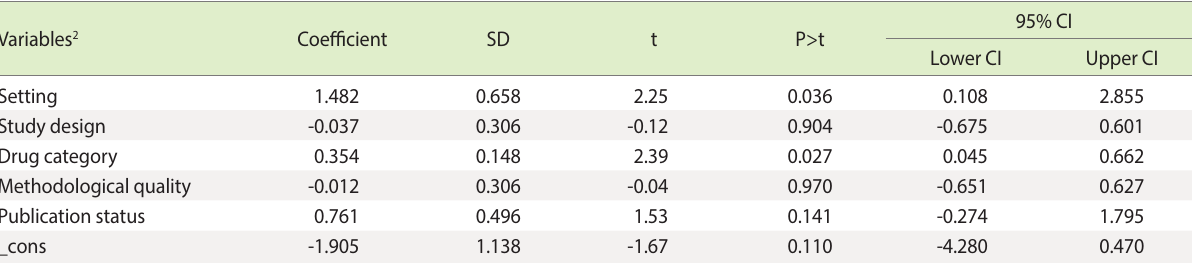
Table 1. Meta-regression of the effects of covariates on the association of antiretroviral therapy and congenital anomalies 1